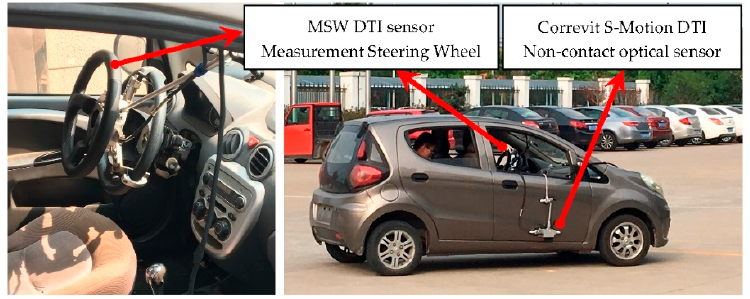
Figure 9. The experimental scene.